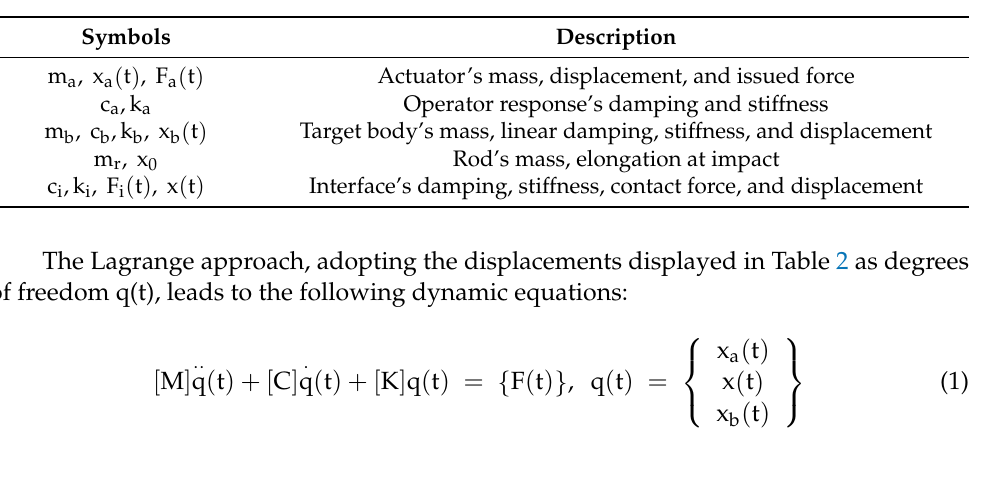
Table 2. Modeled system key parameters list. Symbols refer to Figure 2b. All displacements are referred to the respective equilibrium